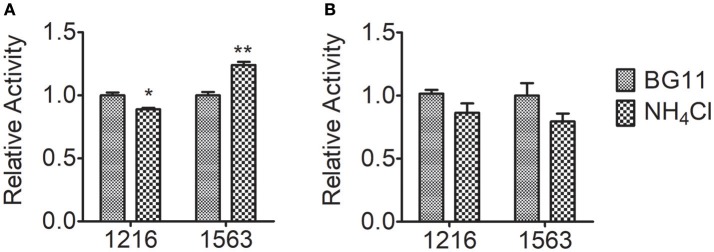
Relative enzyme activity of GS and GOGAT in Chlorella strain FACHB-1216 and FACHB-1563 after incubation for 5 h in BG11 and 1 g L−1 NH4Cl. (A,B) Represent the enzymes GS and GOGAT, respectively. The control (BG11) values were set to 1 to facilitate comparison. The significance of the differences between the control (BG11) and other values was tested using a one-way ANOVA. *P < 0.05; **P < 0.01.